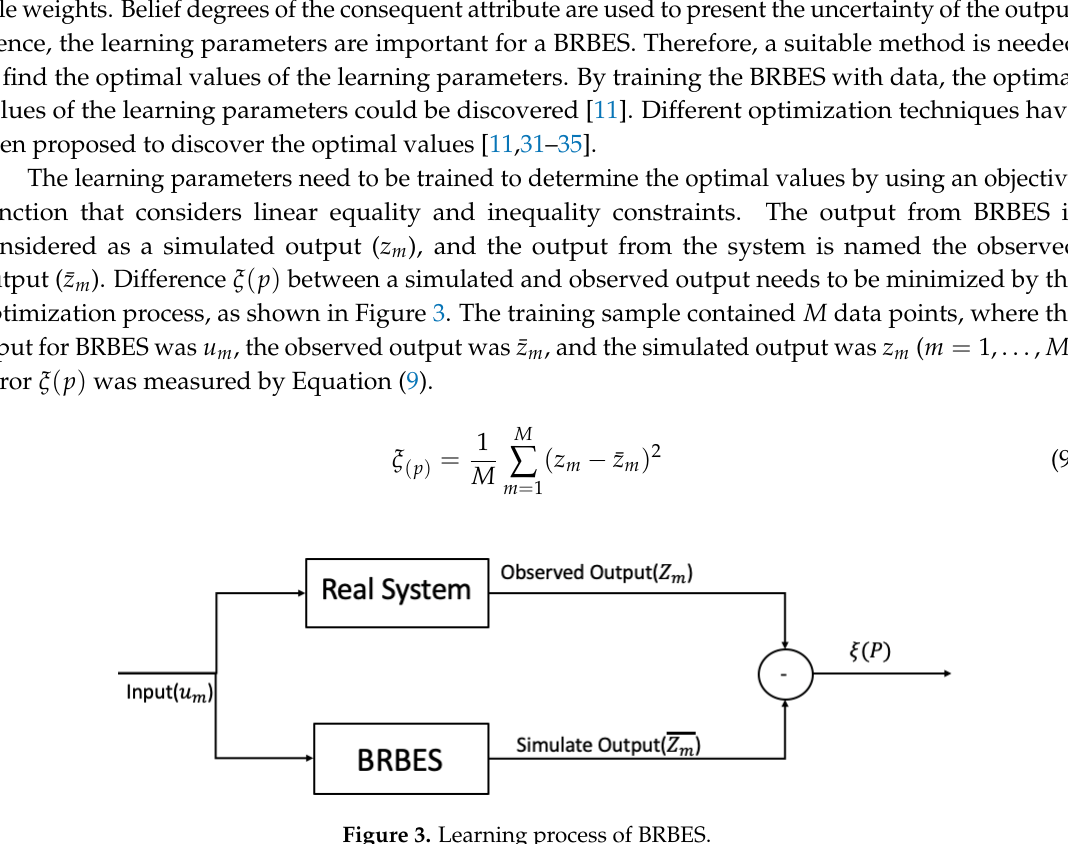
Figure 3. Learning process of